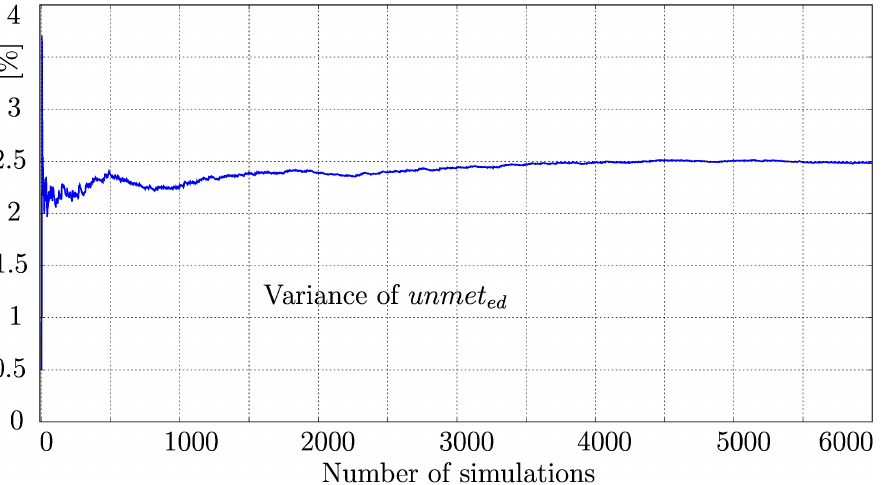
Figure 8. Variance of the unmet electricity demand ( unmet ed ) computed for 6000 simulations using different initial conditions of z